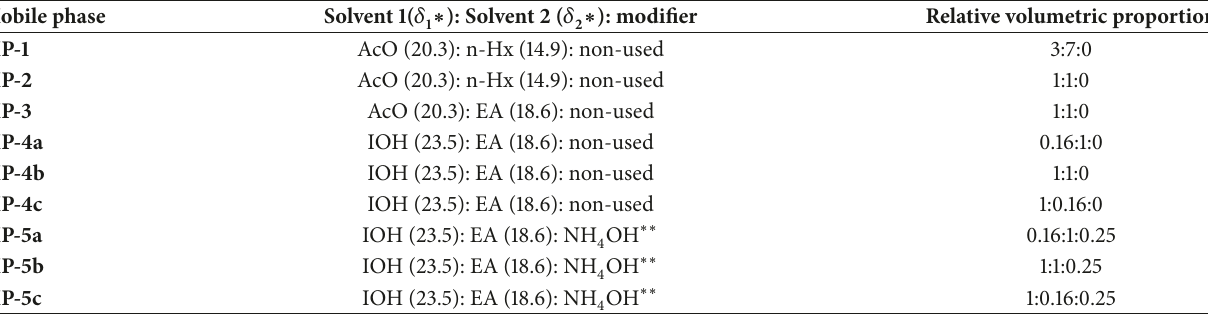
Table 1: Relative volumetric proportion for the mobile phases used to perform the 1D-TLCs and 2D-TLCs. Mobile